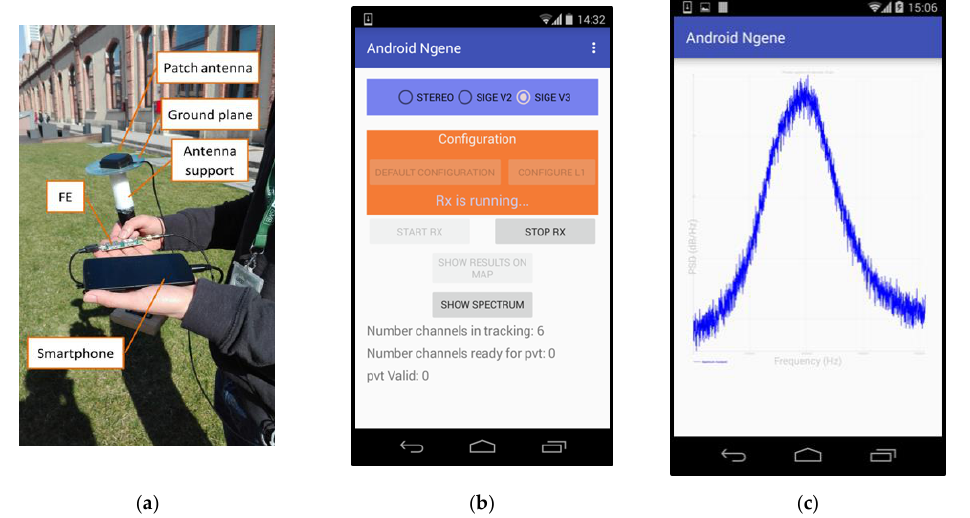
Figure 7. Live experiment test setup ( a ), screenshot of NGeneApp GUI ( b ) and real-time PSD plot ( c ).